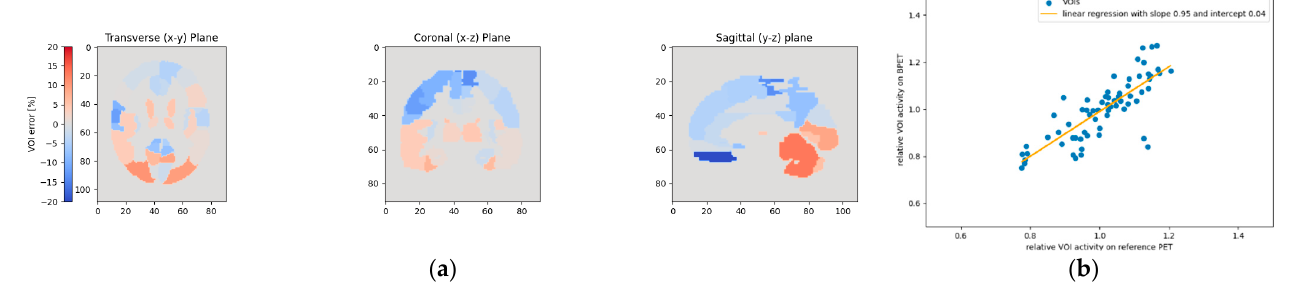
Figure 12. This figure shows the relative VOI deviations for patient P1 with the patient-specific attenuation map in the first row. The middle row shows the smoothed reference PET and the last row the median-filtered BPET reconstruction. Most regions with the largest errors (left cerebellar hemisphere and left fusiform gyrus) were near the area that was outside the BPET field of view due to inaccurate positioning of the patient.